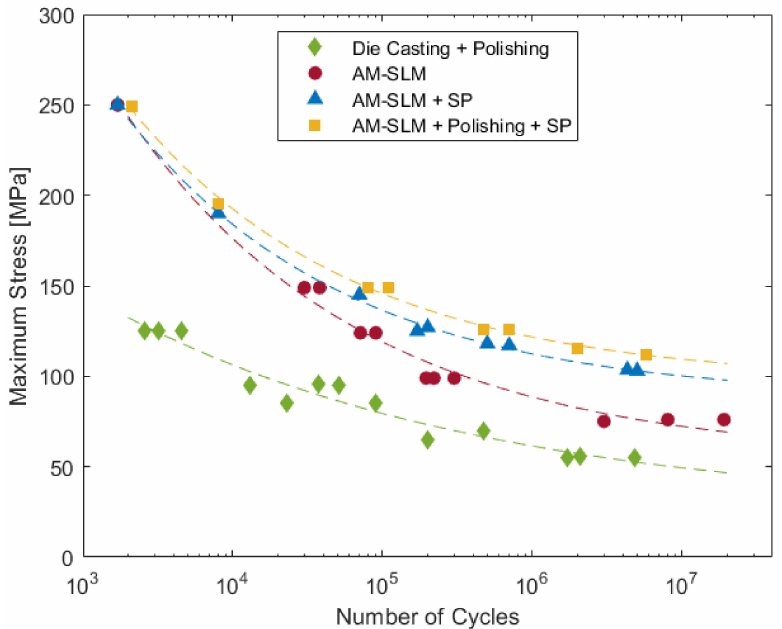
Figure 14. S–N curves of die cast and SLM AlSi10Mg samples in different conditions, namely as-printed, after polishing, and after polishing plus shot peening (SP). Redrawn from ref. [210] (reproduced with permission from Additive Manufacturing; published by Elsevier,